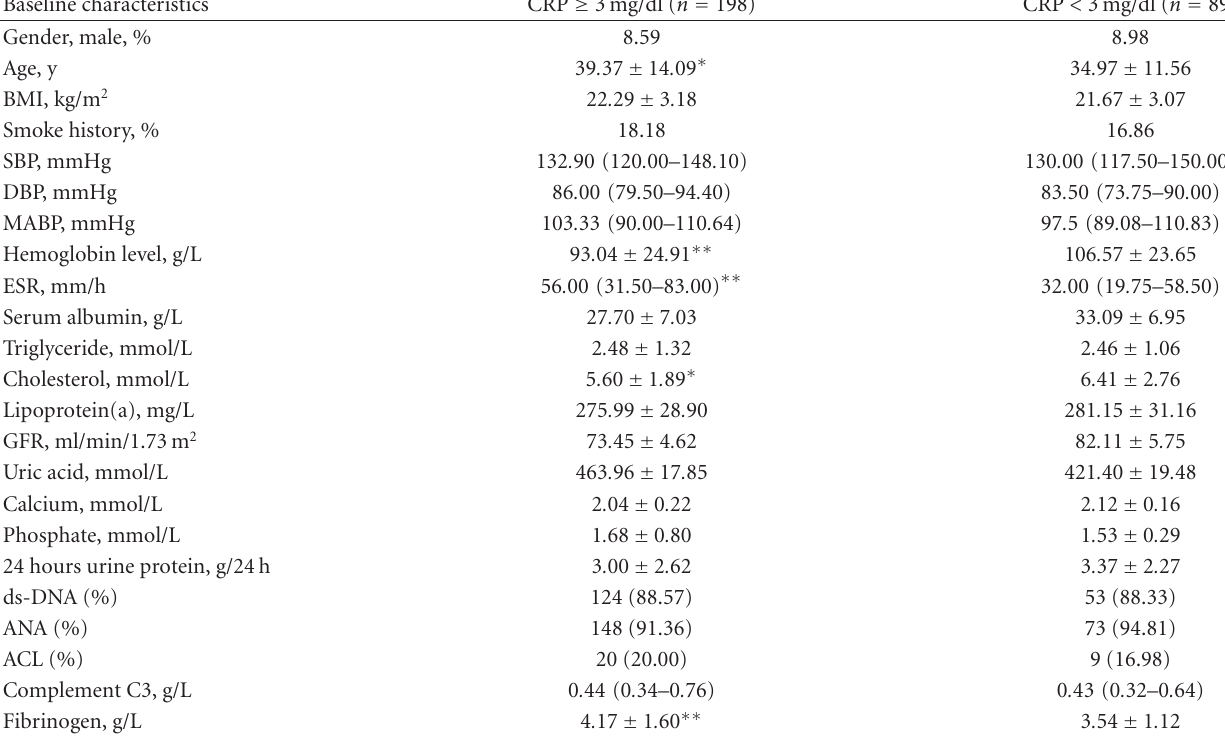
Table 2: Laboratory parameters of LN patients grouped by hs-CRP level.